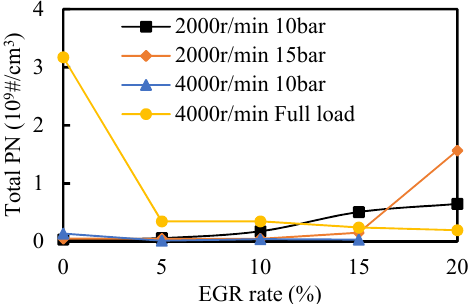
Figure 9. The effect of EGR rate on the concentration of particulate matter. At 4000 r/min, the PN concentration decreased with the increase in the EGR rate. At 4000 r/min and full load, the PN concentration sharply decreased after adding EGR. The main reason is that EGR suppresses the “over-injection” phenomenon, reduces the mixture enrichment, and greatly reduces the PN concentration. It can be seen that at high speeds, increasing the EGR rate can reduce PN emissions.